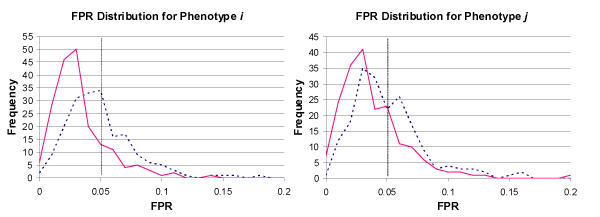
Comparison of FPR when evaluating multiple phenotypes: HM (solid lines) versus LRM (dotted lines).